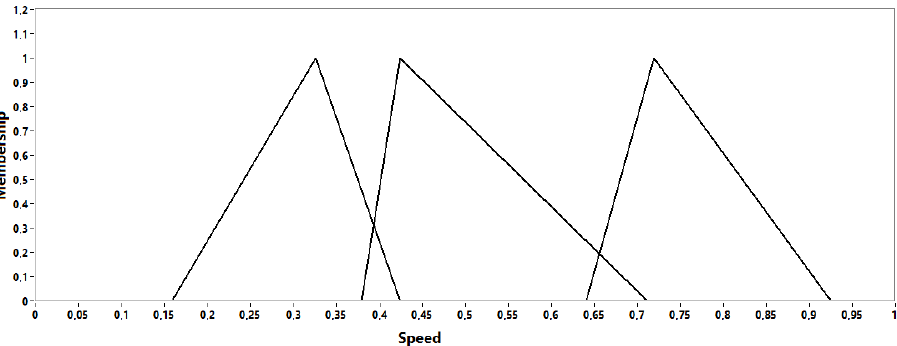
Figure 6. The sets of the safety variable; left set: safe; middle set: acceptable; right set: dangerous.